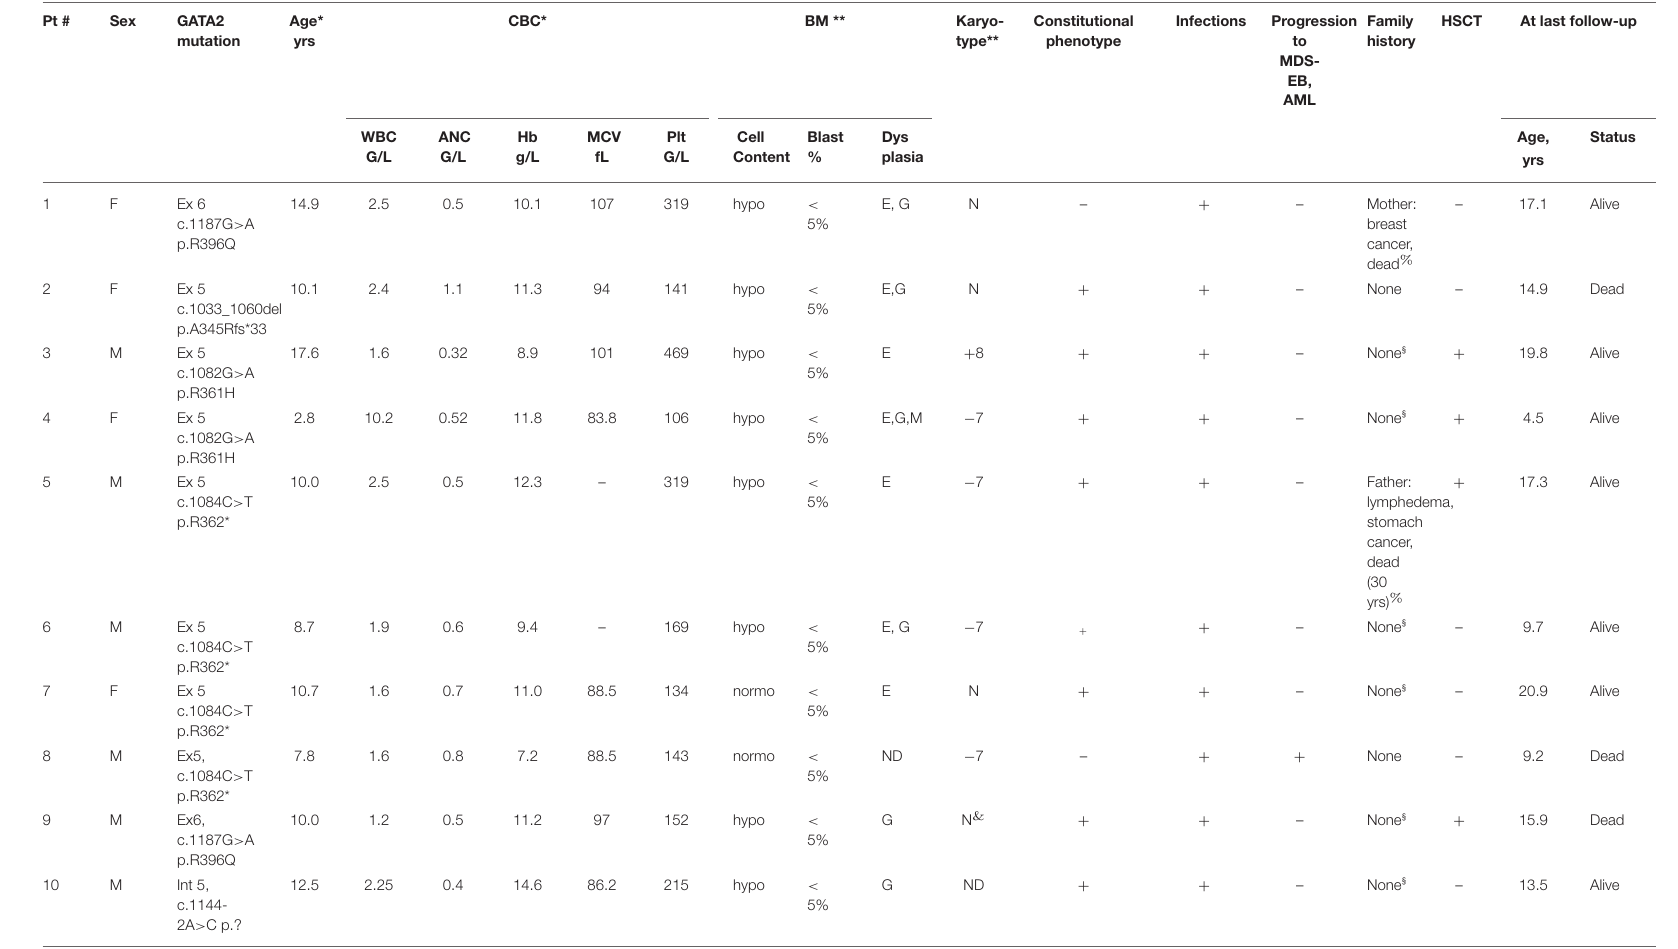
TABLE 1 | Clinical and hematological characteristics of patients with GATA2